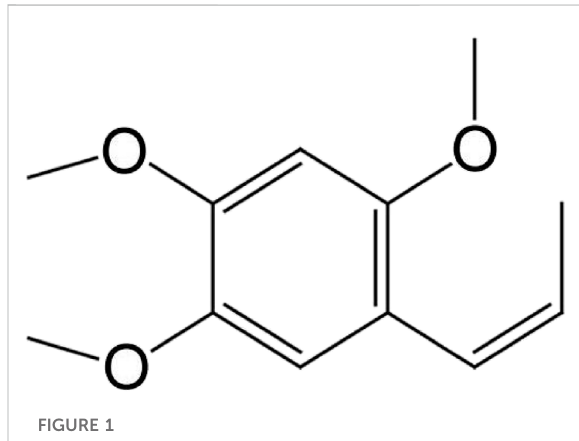
FIGURE 1 Chemical structure of β